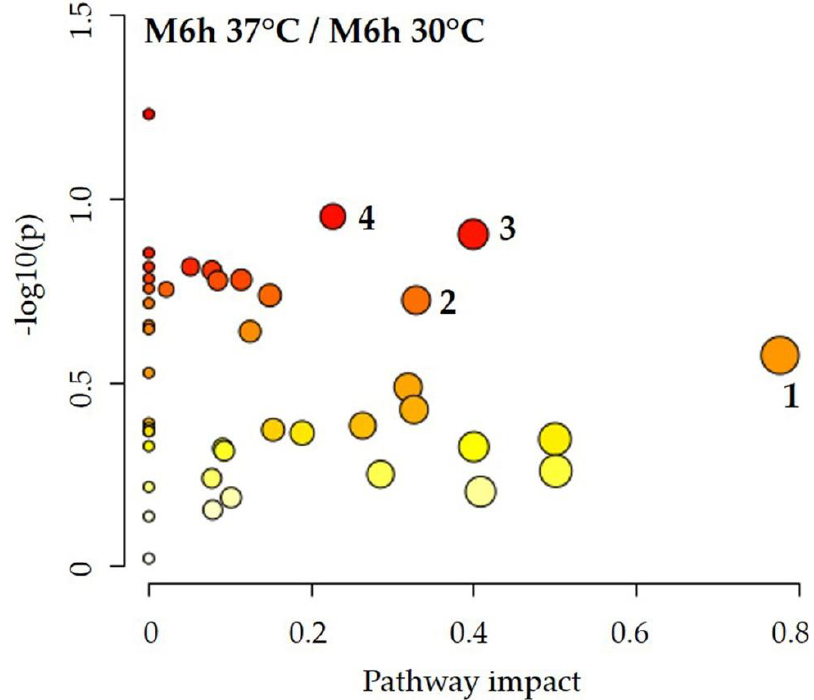
Figure 5. Pathway analysis showing the enriched pathways that arose from comparing the intracel- lular metabolomic datasets obtained in M199 at 30 °C and 37 °C. Matched pathways are displayed as circles. The color of each circle is based on p values (a darker color indicates more significant differences in metabolite concentrations of a specific pathway), whereas the size of the circle corre- sponds to the pathway impact score. The most impacted pathways, despite the low significance ( p > 0.05), are: ( 1) alanine, aspartate, and glutamate metabolism; (2) arginine and proline metabolism; (3) nicotinate and nicotinamide metabolism; (4) pyrimidine metabolism. p values denote enrichment of the entire pathway by Fisher’s exact test.